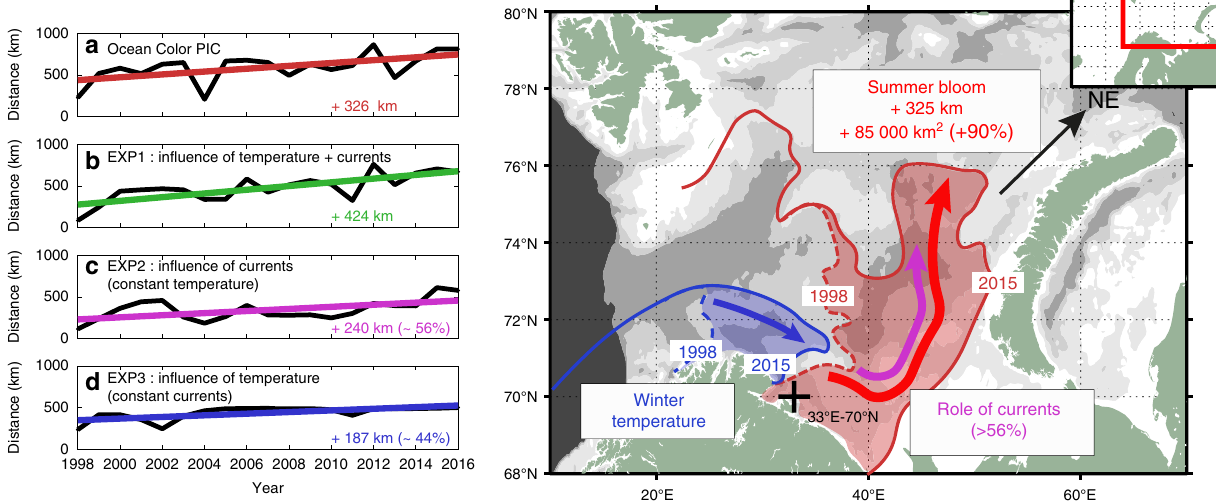
Fig. 5 Shifting position of the leading-edge Ehux bloom distribution. Shifting position from ocean-color PIC ( a ), and the 3 Lagrangian experiments ( b – d ) for the last 19-years (1998 – 2016). The comparison between the 1 st Lagrangian experiment (EXP1, b ) with the 2 nd (EXP2, c ) and the 3 rd (EXP3, d) aims at estimating the relative contribution of currents (EXP2, constant temperature) vs. temperature (EXP3, constant currents) on the total Ehux poleward expansion (EXP1, varying temperature and currents). The right panel is a schematic illustration of the poleward expansion of the Ehux with the winter 4 °C isotherm (lowest temperature for a ‘ regular ’ Ehux growth) in blue and the summer bloom position (northern boundary) in red. The two extreme years 1998 (dashed) and 2015 (solid) are represented. Arrows indicate the contribution from temperature and/or currents keeping the same color